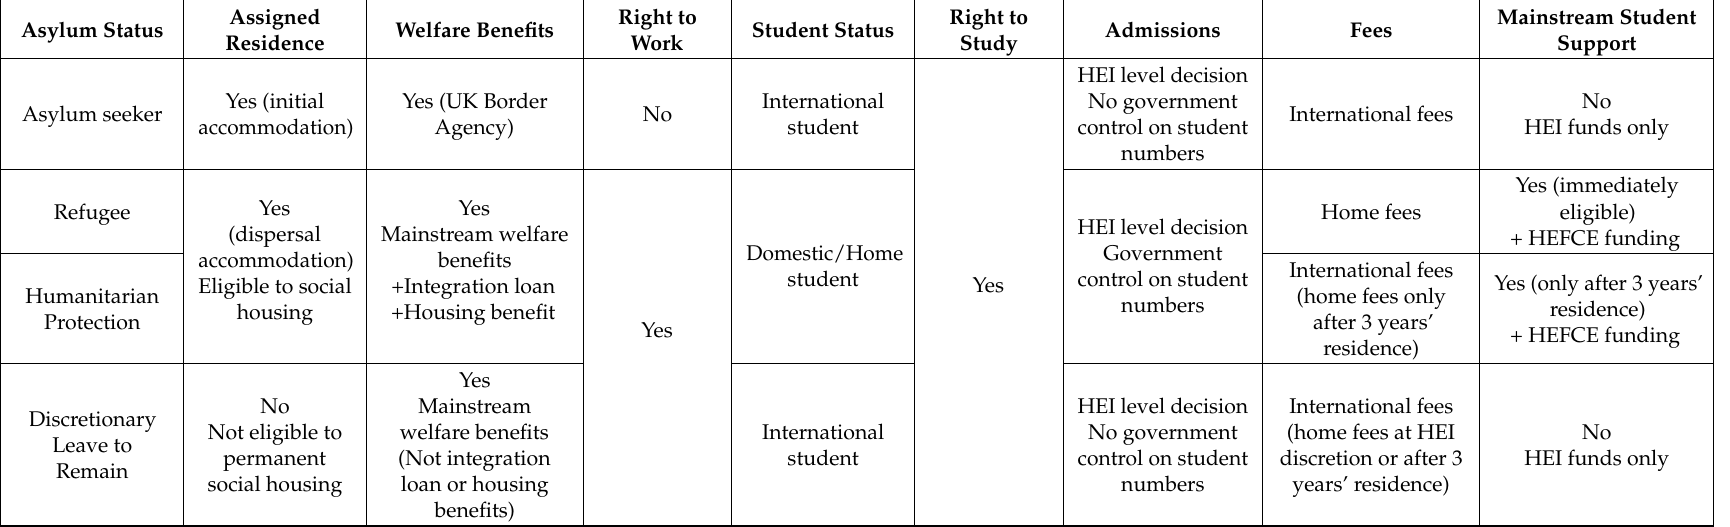
Table 1. Administrative refugee status and corresponding welfare and student rights in